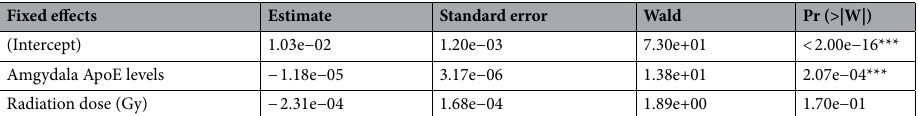
Table 4. Linear generalized estimating equations model results predicting relative amygdala volumes with ApoE levels in the amgydala and radiation dose as independent predictors. *** p < 0.001; displayed p -values are uncorrected for multiple comparisons.